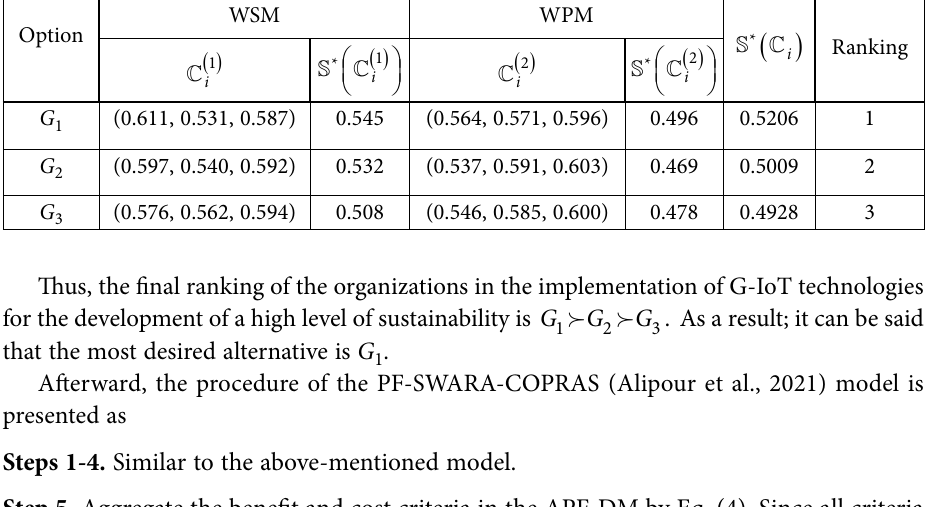
Table 12. The outcome of PF- SWARA-WASPAS model